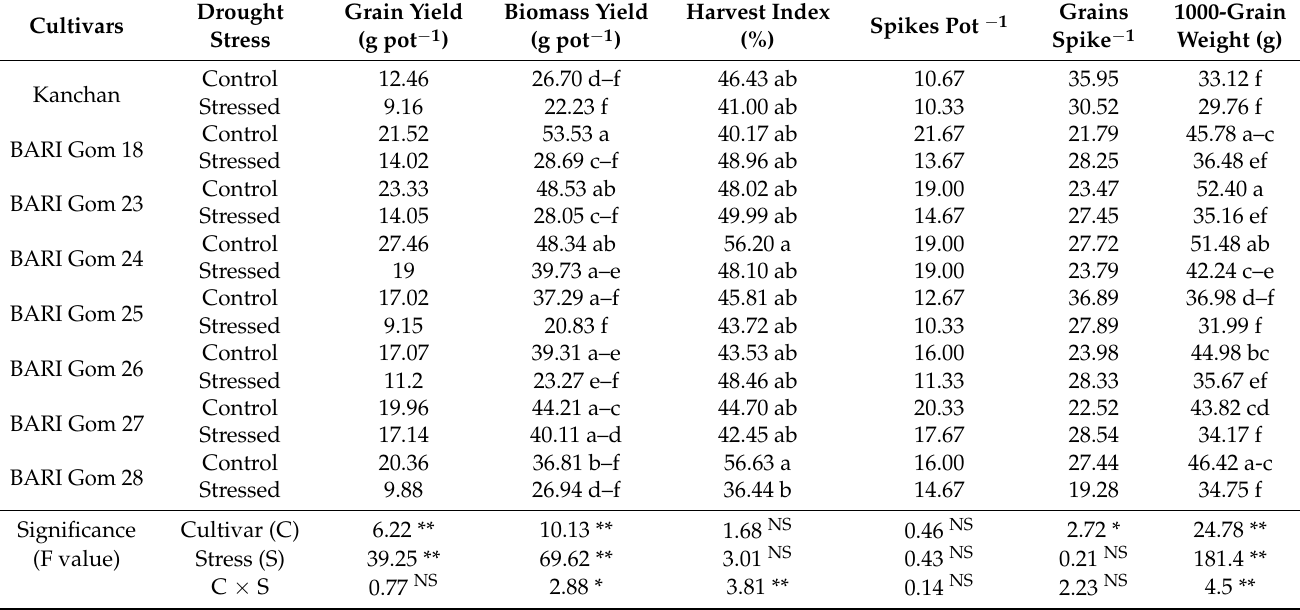
Table 1. Grain yield, biomass yield, harvest index, and yield attributes in eight wheat cultivars as affected by drought stress during grain filling